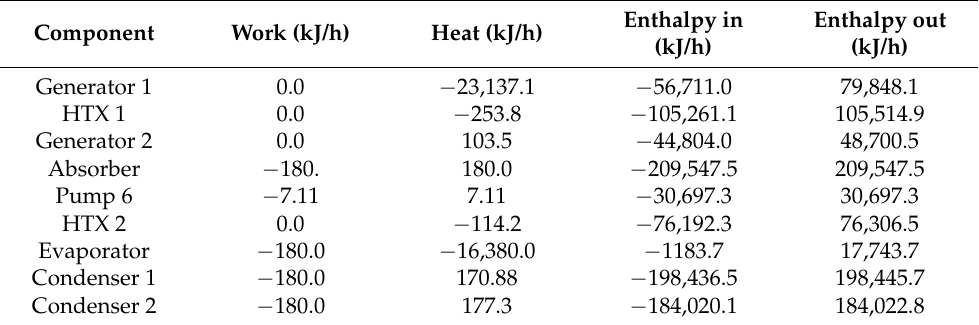
Table 11. Energy conservation for each component in series double-effect LiBr–water absorption refrigerant system shown in Figure 3 (Cooling capacity is 4.6 kW).